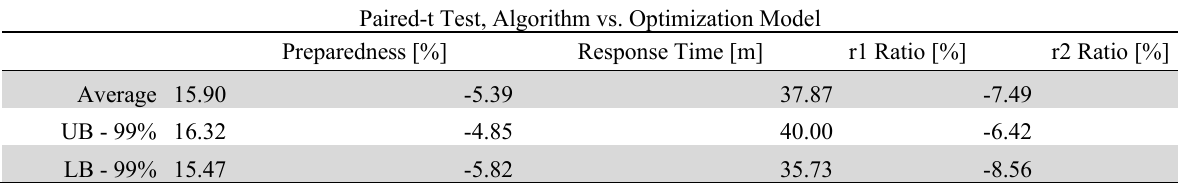
Results of 200 Independent Simulation Replications Paired t Test Paired-t Test, Algorithm vs. Optimization